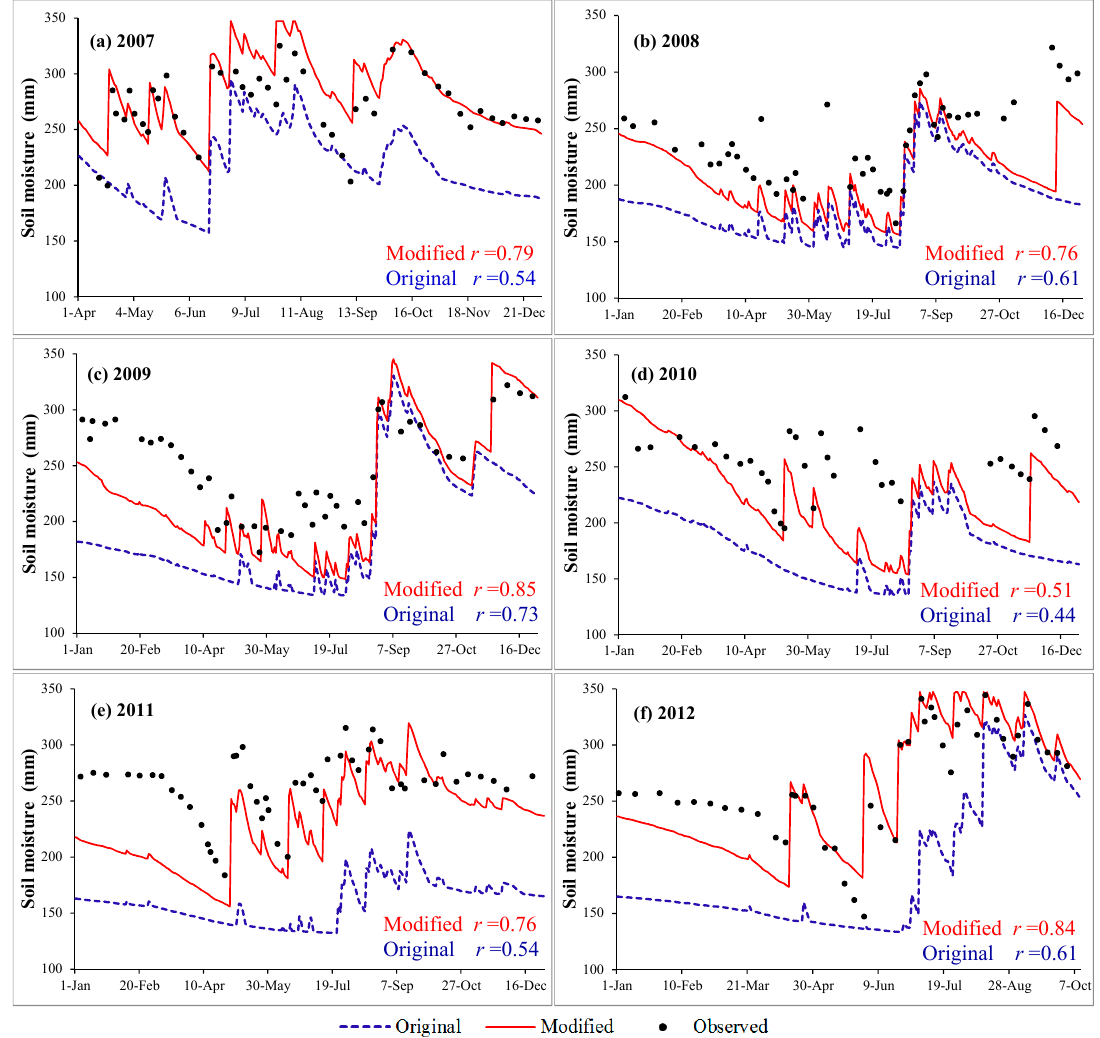
Figure 5. Time series plot of weekly soil moisture from the water balance models and observations in Luancheng in the years ( a ) 2007; ( b ) 2008; ( c ) 2009; ( d ) 2010; ( e ) 2011; ( f ) 2012. The correlation coefficient ( r ) is also shown.